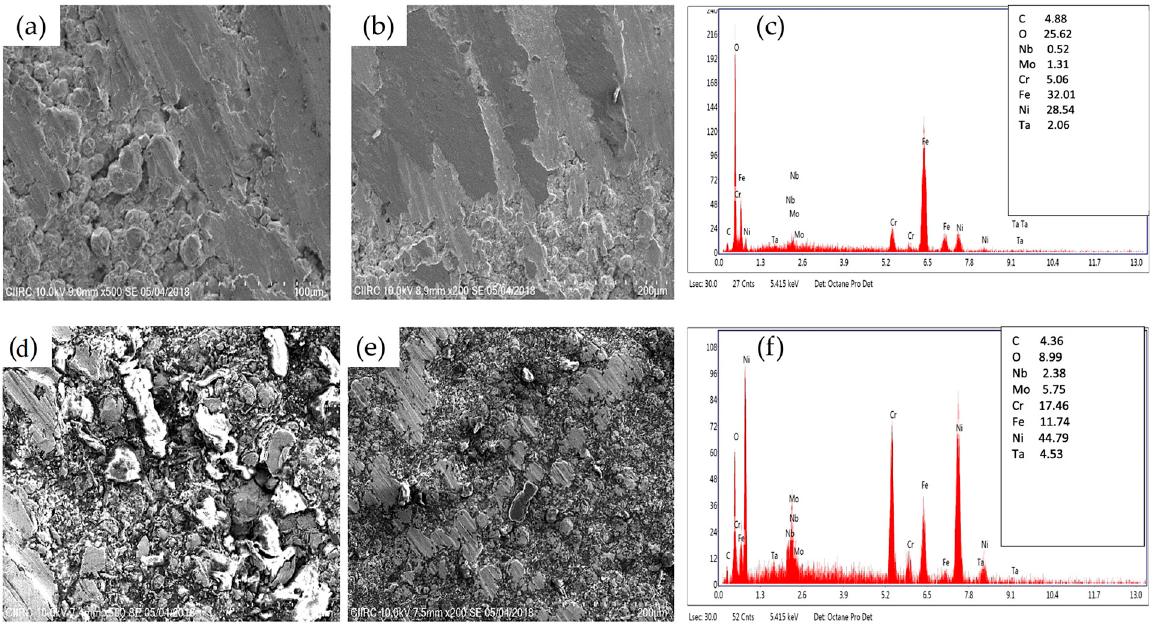
Figure 16. The wear track morphologies of CS IN 625 on SAE213 T11 at ( a , b ) 400 °C and ( d , e ) 200 °C, along with their elemental composition ( c , f ). Reprinted from Padmini et al. [113], Copyright 2020, with permission from Elsevier.